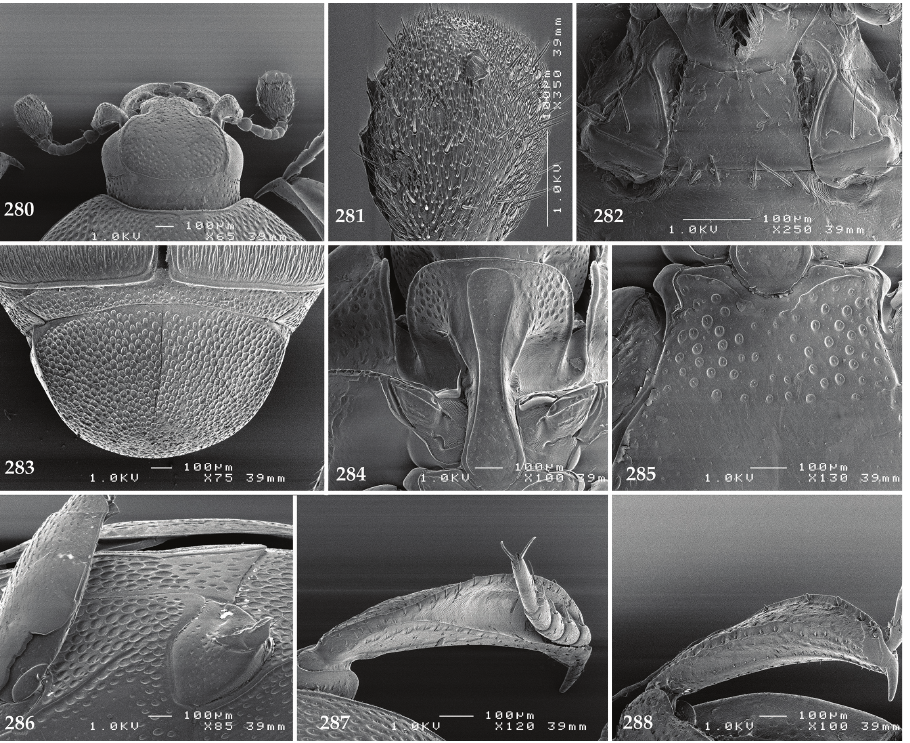
Body (Fig. 279) ovoid, flattened dorso-ventrally, cuticle light brown to castaneous, with slight metallic tinge; ventral side darker than dorsal; legs and body appendages similarly